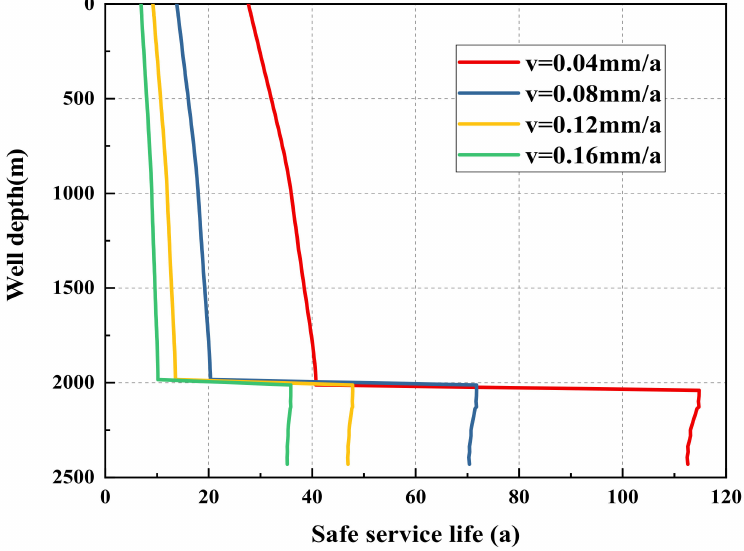
Figure 18. Influence of corrosion rate on the corrosion life of the outer layer of the